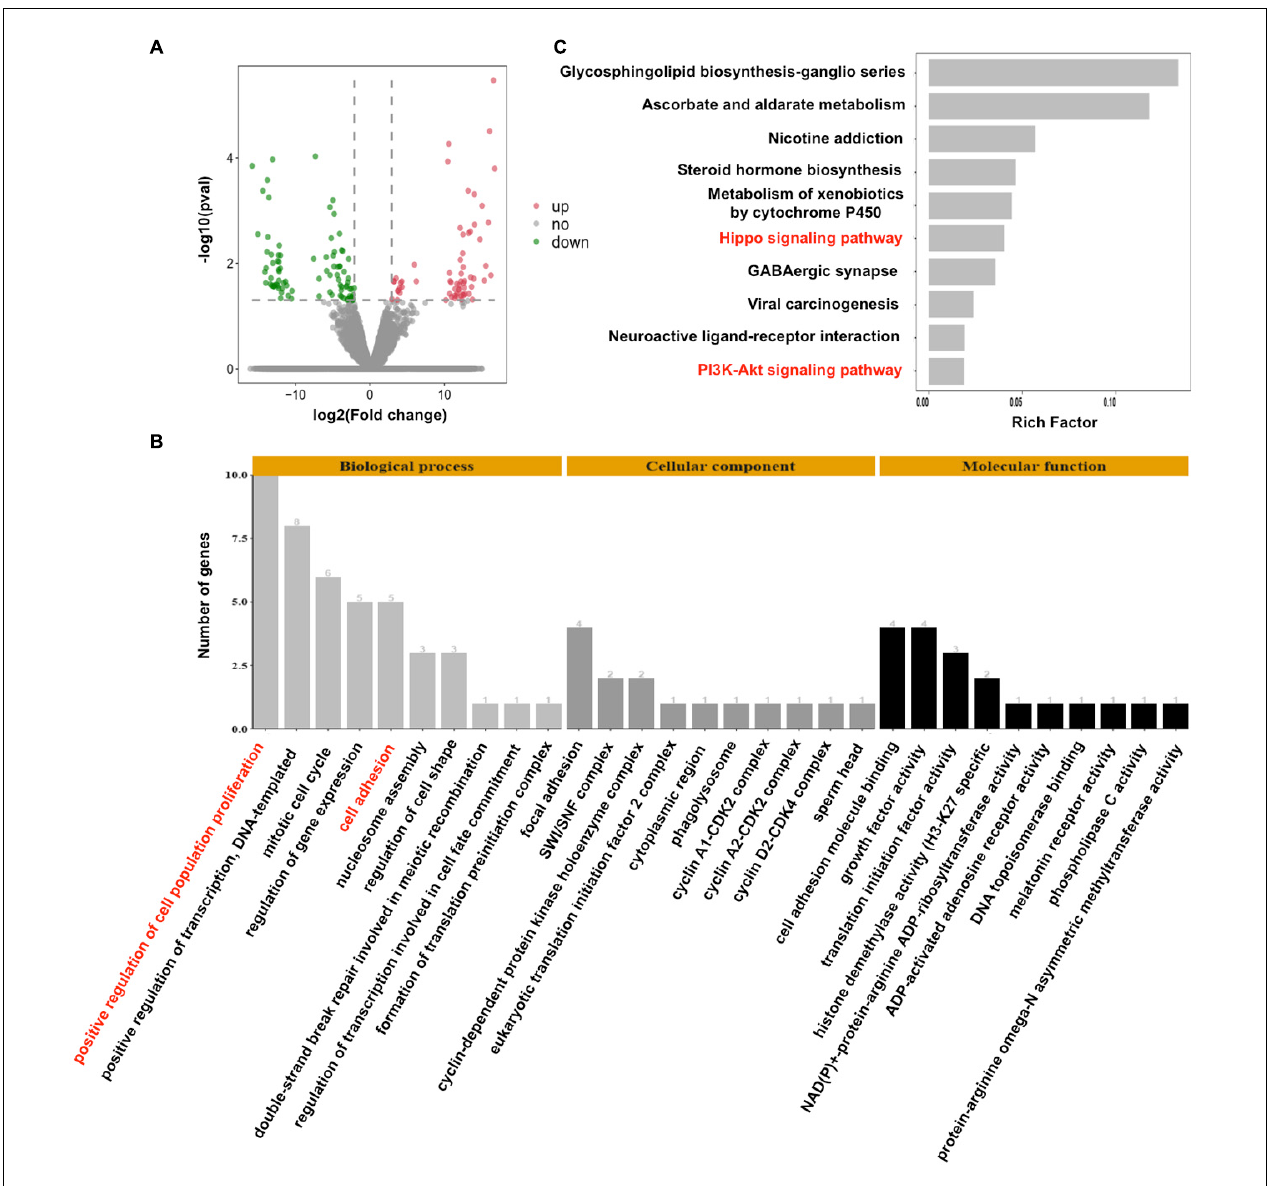
FIGURE 5 | Effect of CARM1 knockdown on the transcriptome in embryos. (A) Volcano plot displaying differentially expressed genes in embryos from control and CARM1 KD groups. Green spots denote the number of downregulated genes; red spots indicate the number of upregulated genes. (B) GO analysis showing the most enriched functional categories enriched by the differentially expressed genes. (C) KEGG analysis showing the top 10 signaling pathways enriched by the differentially expressed